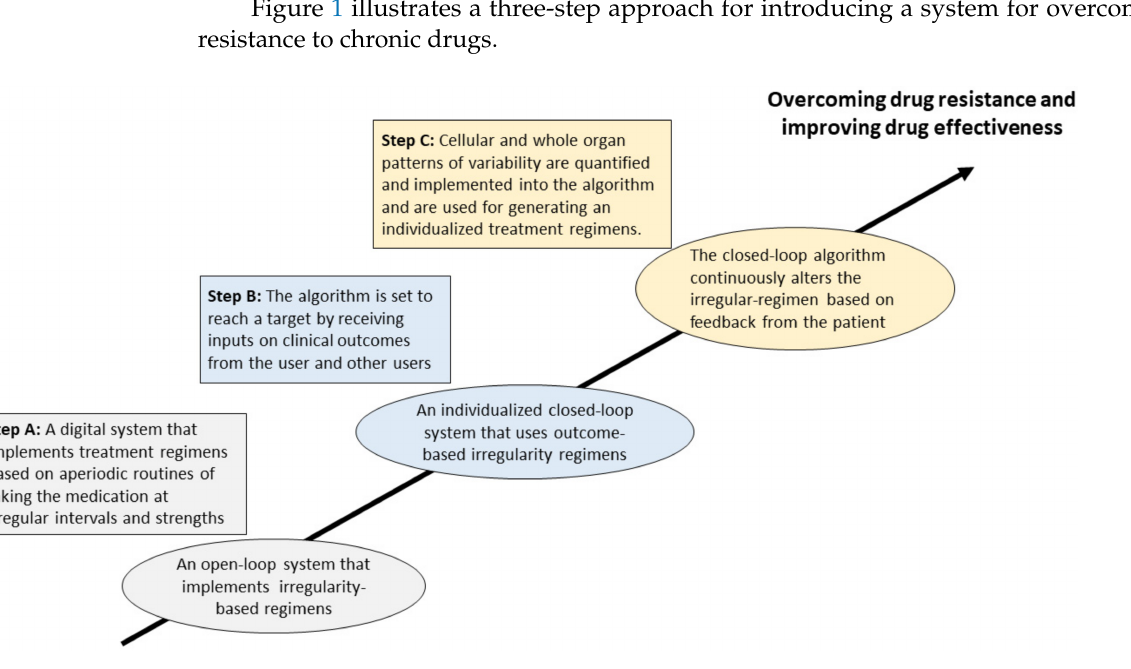
Figure 1. A three-step approach for introducing a system for overcoming drug